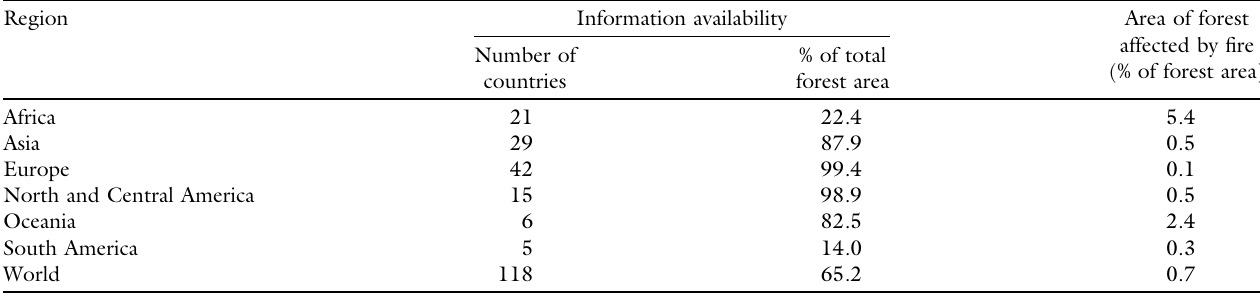
Table 1. Average area of forest annually affected by fire by region, 2005 [35]. Region